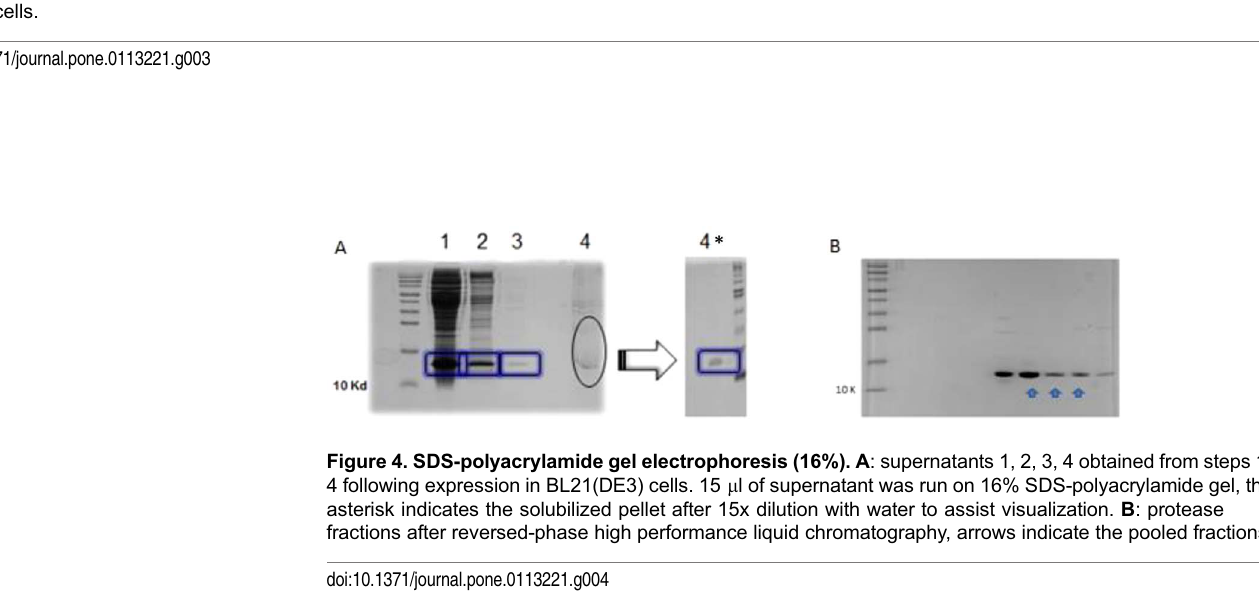
PLOS ONE | DOI:10.1371/journal.pone.0113221 November 24,